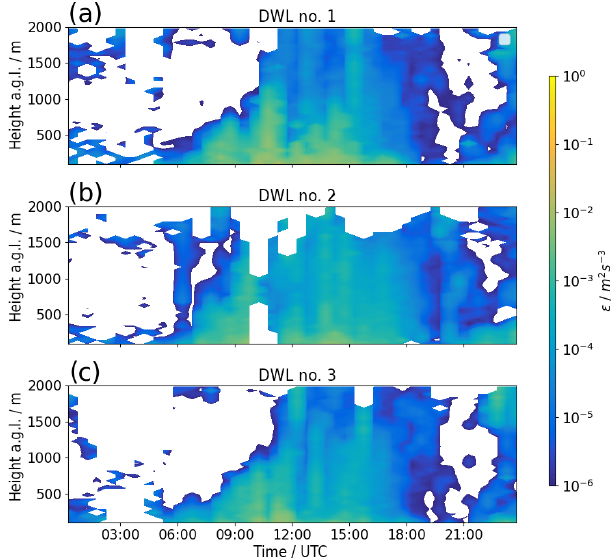
Figure 13. Diurnal cycle of the TKE dissipation rate on 5 June 2018 at the three lidar locations calculated with the W20